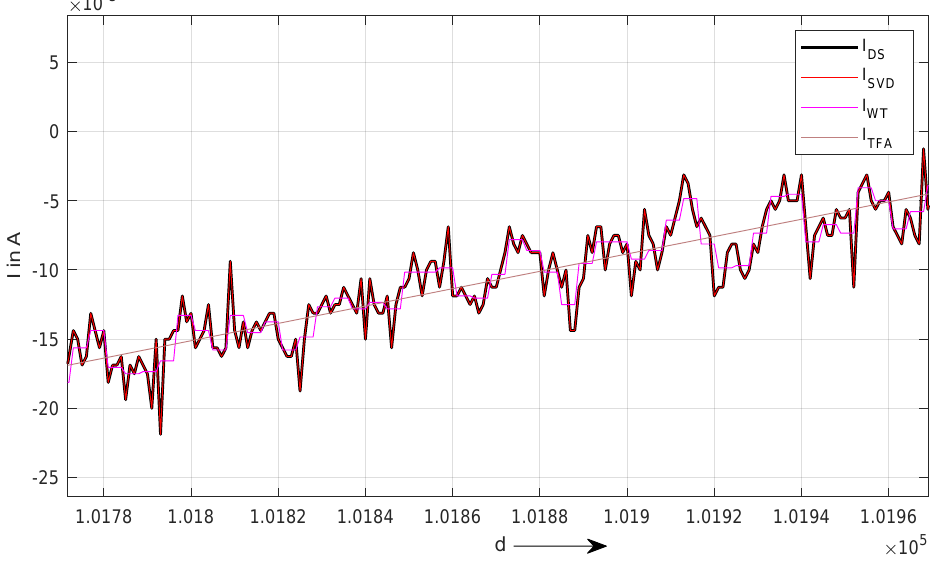
Figure 9. Comparison of I DS and the resulting compression output of the different lossy approaches I DS ( DC )